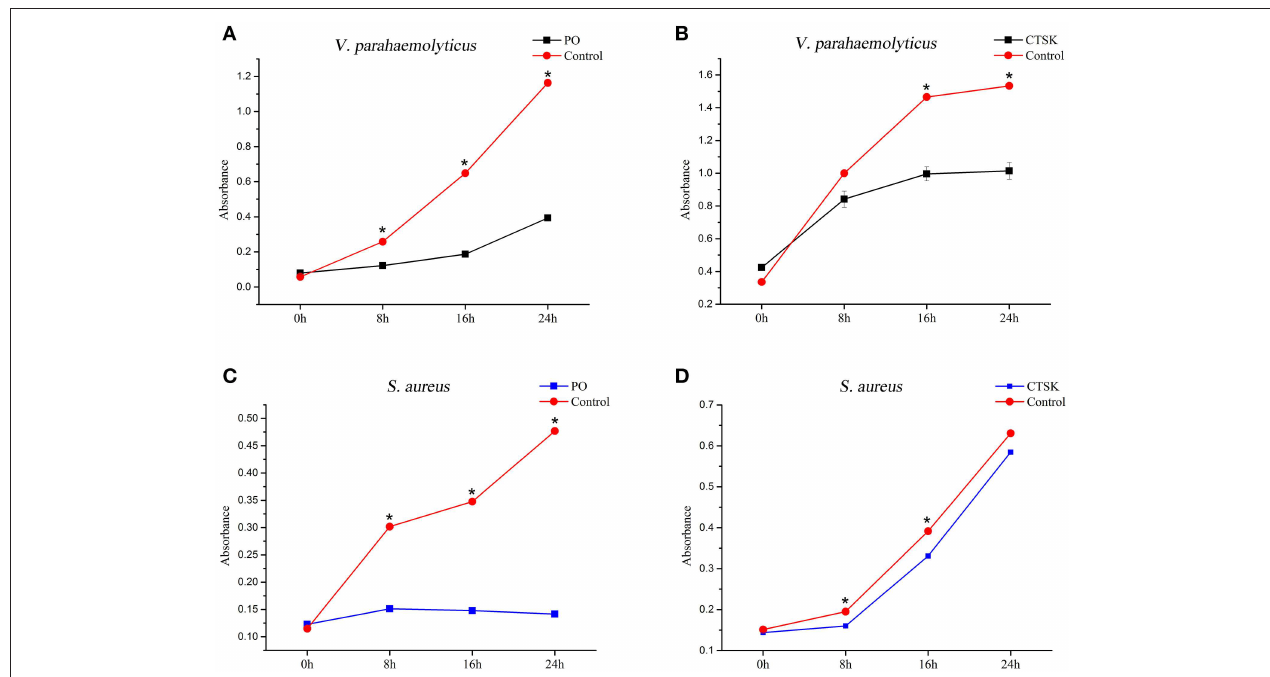
FIGURE 6 | Antibacterial activities of rMpPO and rMpCTSK evaluated by the minimal inhibitory concentration method. (A,B) The inhibition of V. parahaemolyticus growth at 0, 8, 16, and 24h post rMpPO- or rMpCTSK-addition. (C,D) The inhibition of Staphylococcus aureus growth at 0, 8, 16, and 24h post rMpPO- or rMpCTSK-addition. Error bars represent the SD. Asterisks (*) represent a significant difference between groups given rMpPO/rMpCTSK and the control group ( P < 0.05).